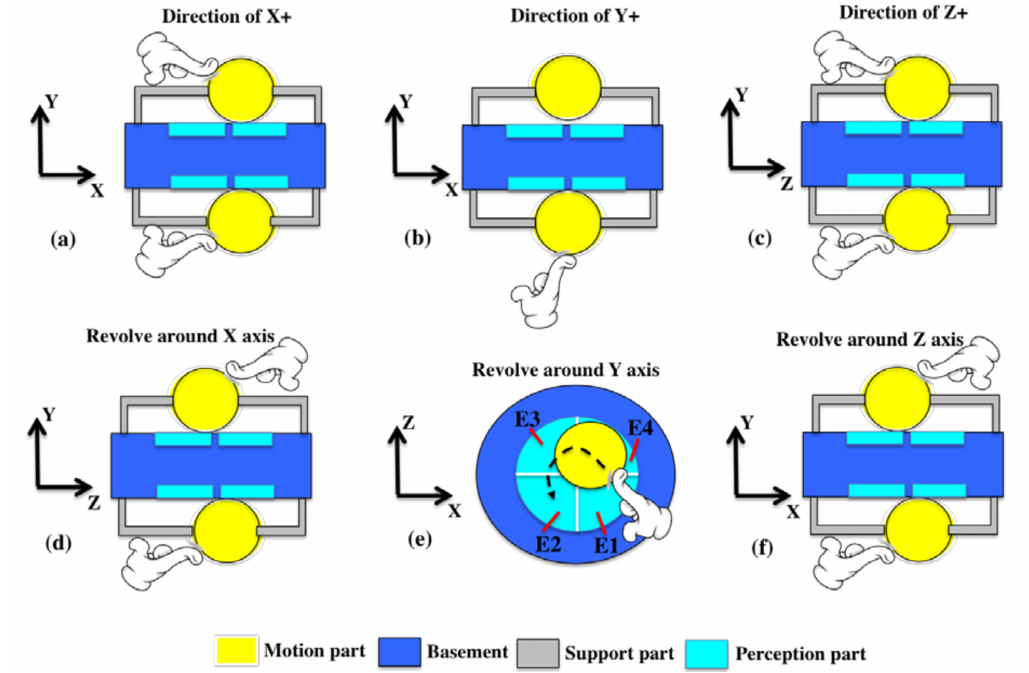
Figure 1. Schematic diagram of six-axis attitude detection. ( a ) In the XY plane, the fingers push both spheres to the X direction at the same time. The signals in the X direction will be detected simultaneously in the upper and lower perception part on the right side. ( b ) In the XY plane, the fingers push the sphere to the Y direction. The signals in the Y direction will be detected in the lower perception part. ( c ) In the YZ plane, the fingers push both spheres to the Z direction at the same time. The signals in the Z direction will be detected simultaneously in the upper and lower perception part on the right side. ( d ) In the YZ plane, the fingers push the spheres along the two opposite directions of the Z axis, and the signals of rotation around the X axis will be detected by the perception parts in the upper left and lower right. ( e ) In the XZ plane, the fingers push the spheres along the path shown in the figure, and the signals around the Y axis will be detected by the four perception parts in turn. ( f ) In the XY plane, the fingers push the spheres along the two opposite directions of the X axis, and the signals of rotation around the Z axis will be detected by the perception parts in the upper left and lower